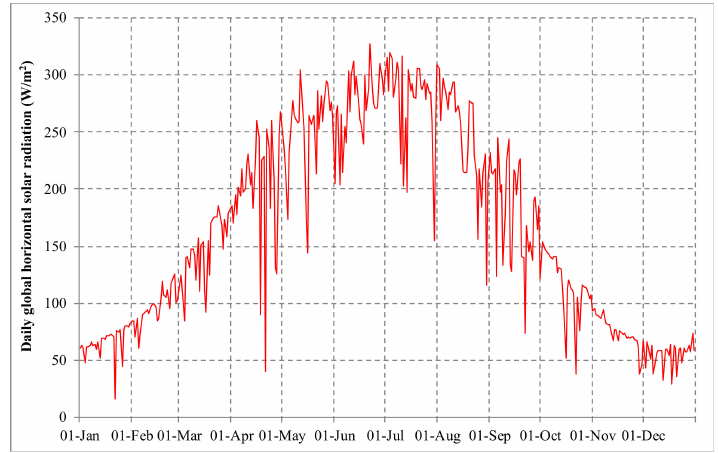
Figure 4. Trend of the solar radiation during the monitoring period.